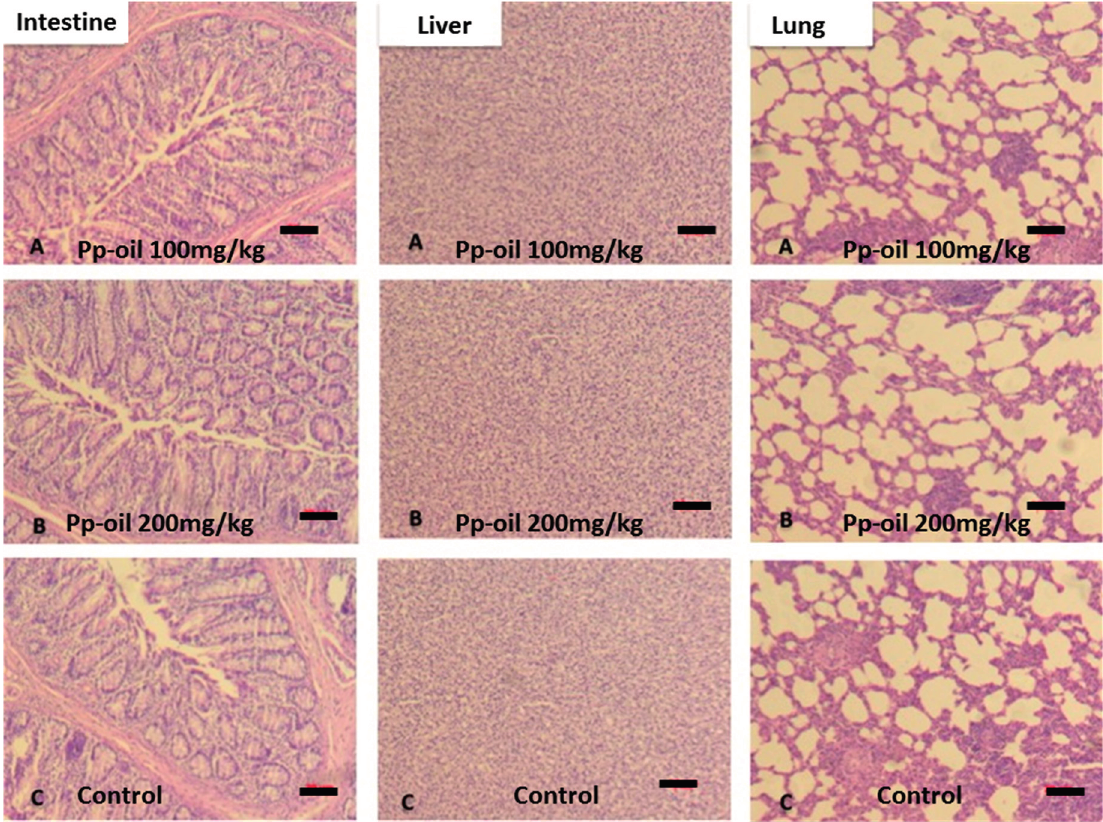
Figure 2. Histopathology of intestine, liver and lung: ( A ) 100 mg/kg; ( B ) 200 mg/kg and ( C ) control. Dark bar: 20 μ